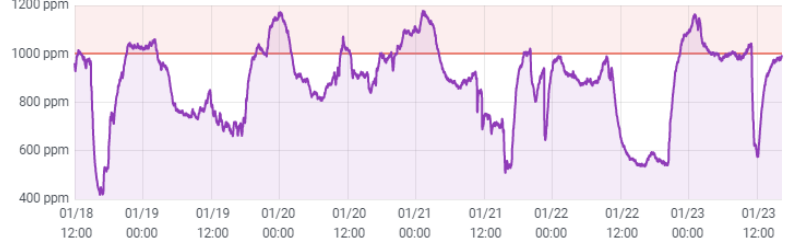
Figure 5. Indoor CO 2 concentration level over 5-day period.